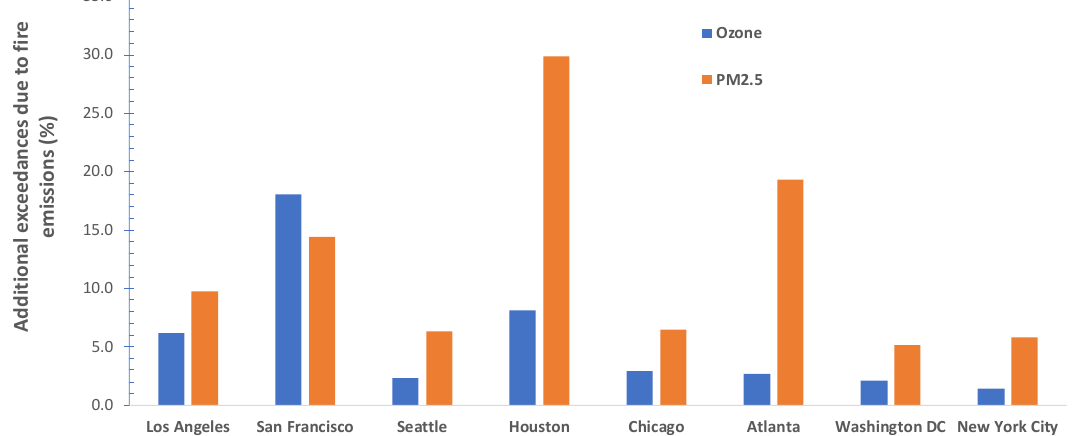
Figure 9. Percentage changes in surface O 3 and PM 2.5 exceedances due to the addition of fire emissions in the selected metropolitan areas over